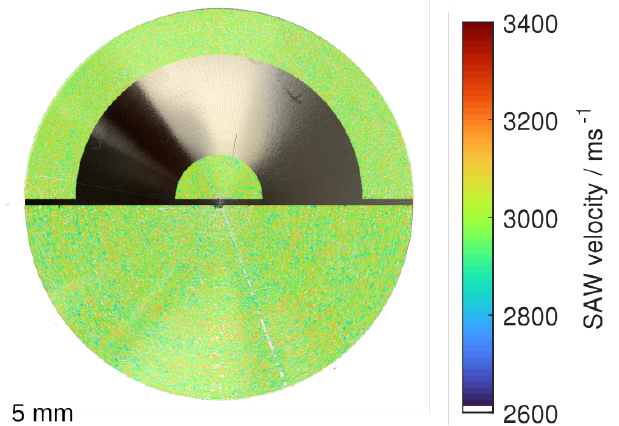
Figure 10. Commercially pure titanium sample; the sample was polished, then milled twice over, creating a rough surface, with SRAS measurements captured after each step. Optical maps of the surface are shown in the left column with velocity maps to the right.